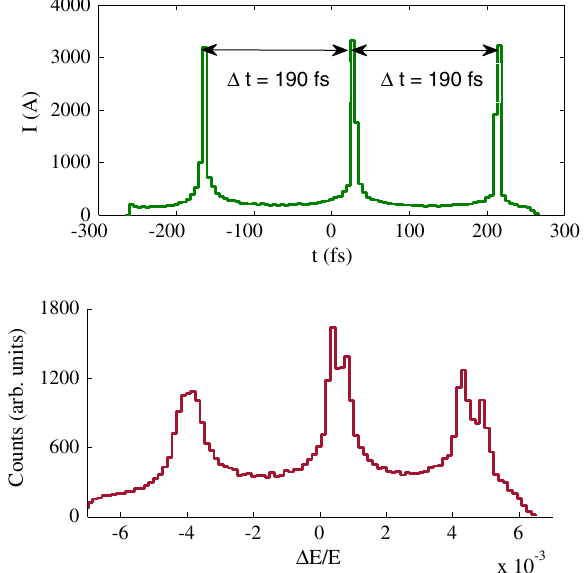
FIG. 9. Current profile corresponding to the configuration ¼ 1 a ¼ 1 mm, L P